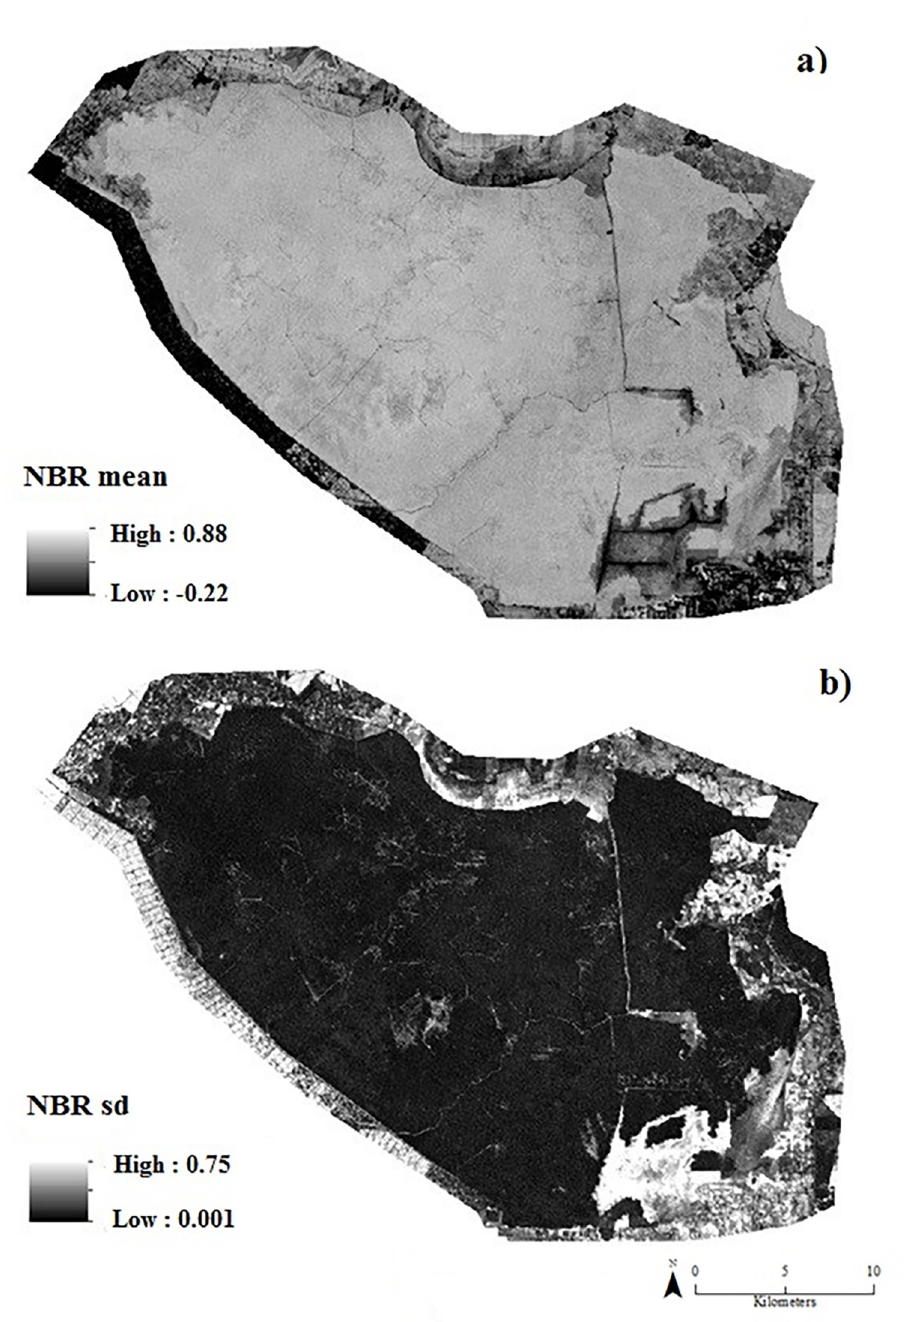
Fig 5. Remote sensing derived products: (a) Normalised Burn Ratio (NBR) mean; (b) Normalised Burn Ratio (NBR) standard deviation